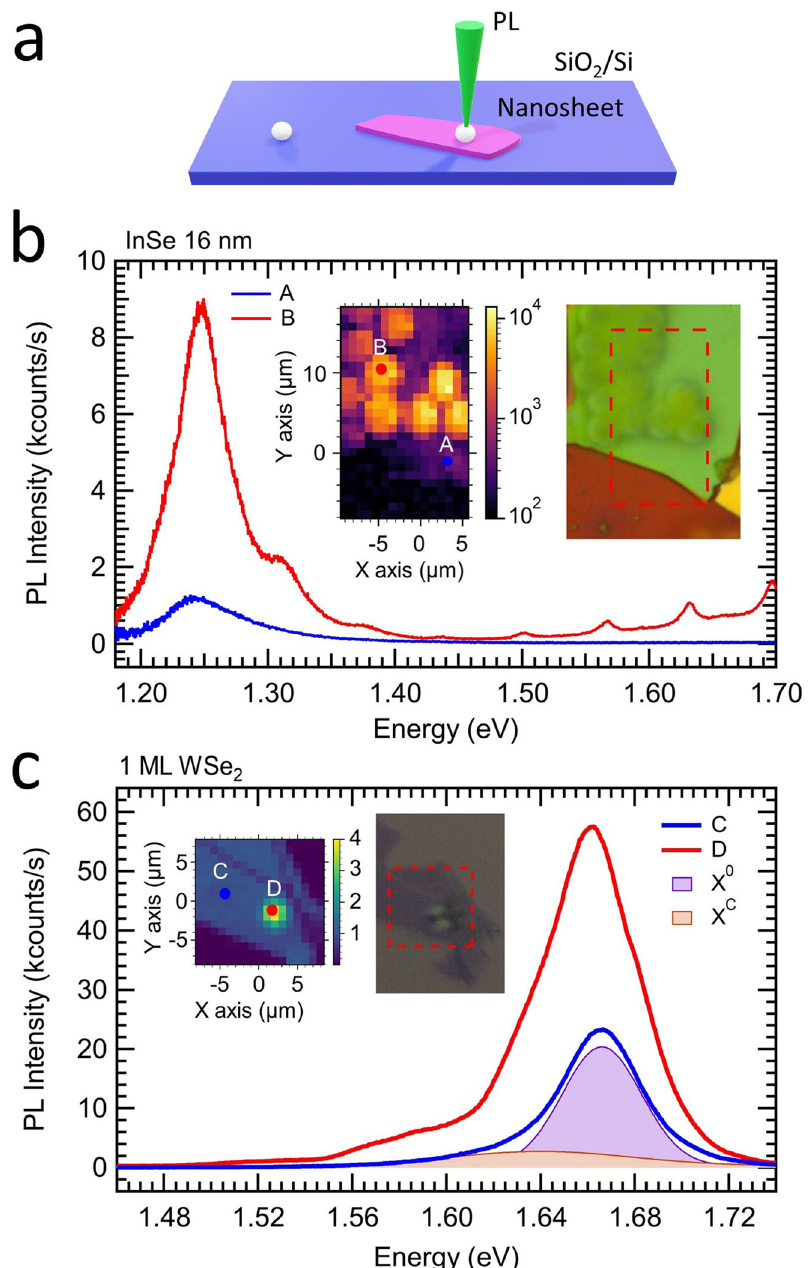
Fig. 1 Photoluminescence response of 2D nanosheets partly covered with SiO 2 microspheres. a Illustration of the measurement process of the PL response of nanosheets partly covered by dielectric microspheres. b Micro-PL spectra acquired in two points of the 16-nm-thick InSe nanosheet deposited on a SiO 2 /Si substrate, which is shown in the optical image in the inset. A certain number of microspheres can be observed in the optical image, as blurred spheres since the image was taking focusing on the nanosheet. The inset includes a PL map acquired in a region of the nanosheet delimited by the red dashed rectangle depicted on the optical image. The PL-signal integrated intensity of each point of the PL map follows the color-code indicated on the right side of the PL map, revealing a clear PL intensity enhancement in the region of the nanosheet covered with microspheres. The two μ -PL spectra shown in the main graph were acquired in each one of the two points marked in the PL map, one in a bare region of the nanosheet (A point) and the other in a point covered by a microsphere (B point). c Micro-PL spectra acquired in two points of a monolayer WSe 2 nanosheet deposited on a SiO 2 /Si substrate, which is shown in the optical image in the inset. In this case, a microsphere was purposely pushed on top of the WSe 2 nanosheet, which appears on the optical image as a burred bump. The inset includes a PL map acquired in a region of the nanosheet delimited by the red dashed rectangle depicted on the optical image. As before, the PL map reveals a clear PL intensity enhancement in the region of the nanosheet covered with the microsphere. The two μ -PL spectra shown in the main graph were acquired in each one of the two points marked in the PL map, one in a bare region of the nanosheet (C point) and the other on a point covered by a microsphere (D point). The μ -PL spectrum measured in the C point was deconvoluted into two gaussian components (shown on the graph), one attributed to the neutral exciton X 0 and the other to charged excitons X c .